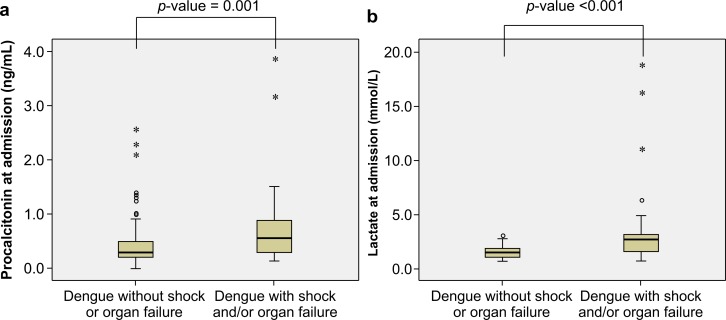
Serum procalcitonin and peripheral venous lactate at admission in dengue patients.(A) Serum procalcitonin levels among patients with and without dengue shock and/or organ failure. (B) Peripheral venous lactate levels among patients with and without dengue shock and/or organ failure. Data are presented as box and whisker plots with median (horizontal line), interquartile range (box), maximum value within 1.5 of interquartile range (whiskers), outliers (circles), and extreme outliers (asterisks).